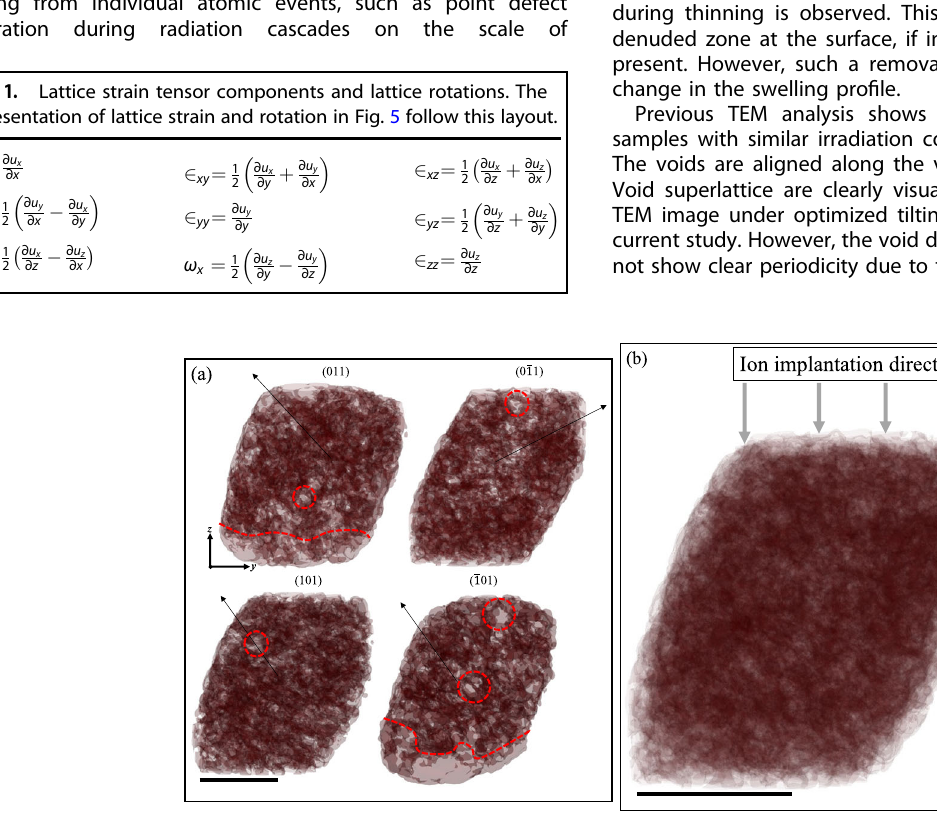
Fig. 3 3D visualization of defects structures. The particle shape is shown as a semi-transparent isosurface, and the defects clusters are shown in brown color while defects free region are highlighted in red circles and lines. a Semi-transparent 3D rendering of the electron density amplitude recovered from BCDI measurements of four different re fl ections. The (011) and ( 1 01) re fl ections show a layer of a denuded zone as shown by the red broken lines. The Bragg vector direction for each re fl ection is indicated by the black arrows. The scale bar is 1.0 µm long in each case. b The defects distribution across the sample is well visualized by the superimposition of each Bragg ’ s re fl ection on the recovered sample morphology.